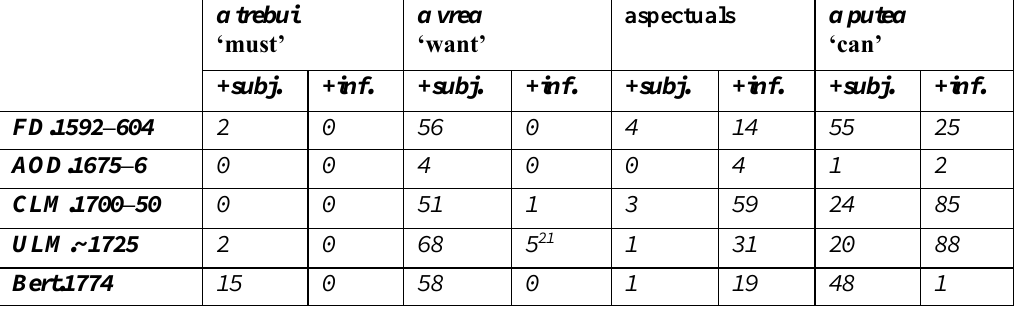
Table 3. The structure of old Moldovan complex predicates a trebui a vrea aspectuals a putea ‘must’ ‘want’ ‘can’ +subj. +inf. +subj. +inf. +subj. +inf. +subj. +inf. 0 0 0 51